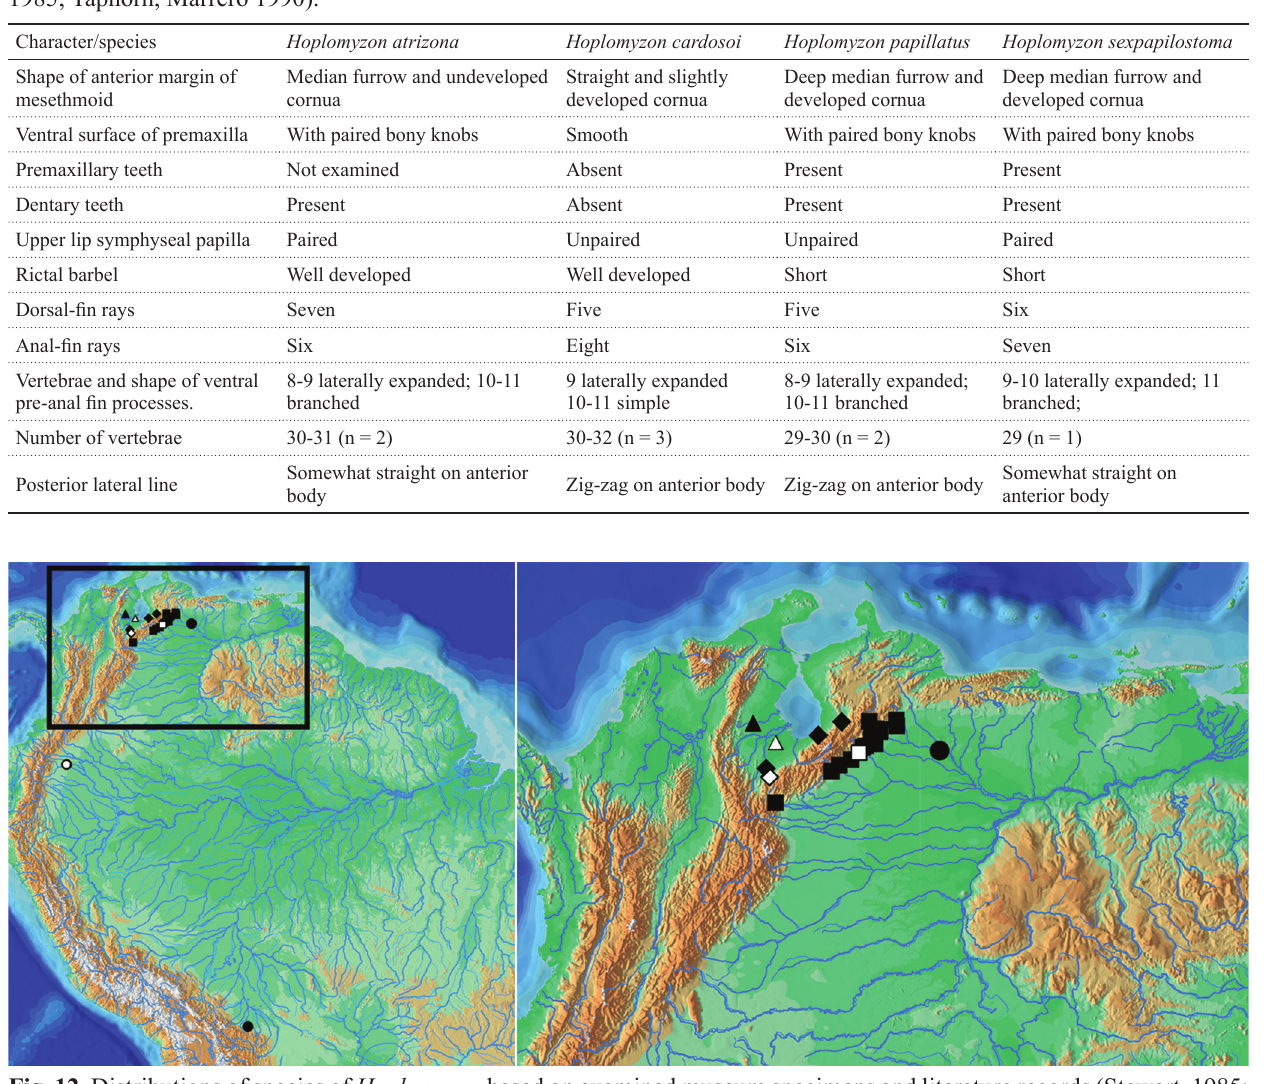
Fig. 12. Distributions of species of Hoplomyzon based on examined museum specimens and literature records (Stewart, 1985; Taphorn, Marrero, 1990). Triangles: H. cardosoi ; diamonds: H. atrizona ; circles: H. papillatus and squares: H. sexpapilostoma . White symbols represent respective type localities. One symbol may represent more than one